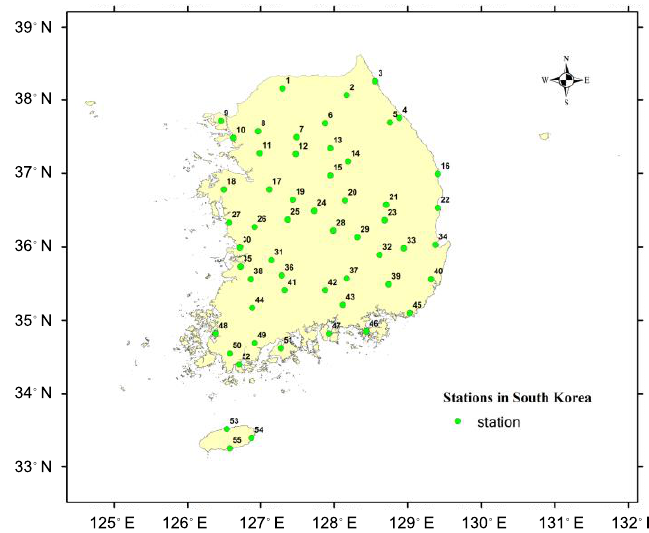
Figure 1. Map of the locations of the stations used in this study. Table 1. Structure of the ANN models used for the